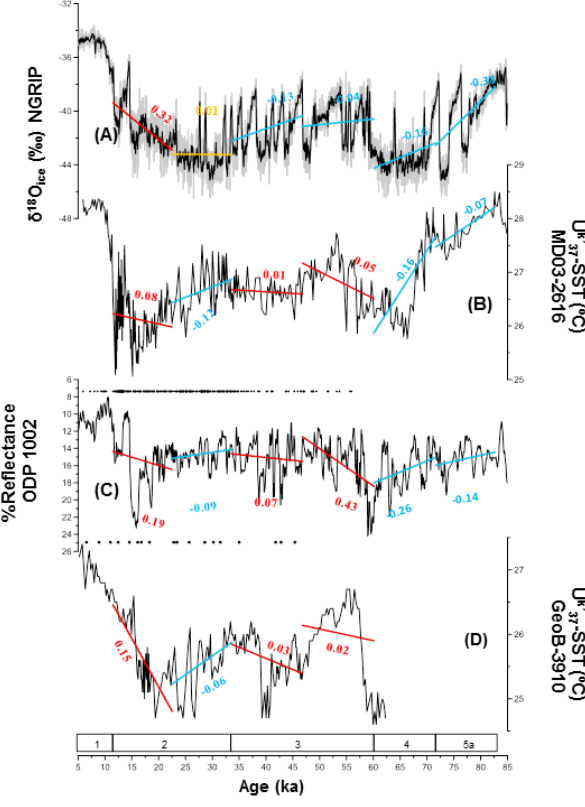
Figure 5. Glacial see-saw between Greenland and Guiana. (a) δ 18 O ice measured in NGRIP (NGRIP, 2004; Wolff et al., 2010). (cid:48) -SST (this study). (c) % reflectance in ODP (b) MD03-2616 U k 37 1002, Cariaco (Peterson et al., 2000). (d) GeoB-3910 U k north-eastern Brazil (Jaeschke et al., 2007). The trends between pre- cession maxima and minima and vice-versa are shown. The num- bers close to the trends refer to the values in Table 2. Radiocarbon dates are drawn as dots on the top of the ODP 1002 and GeoB-3910